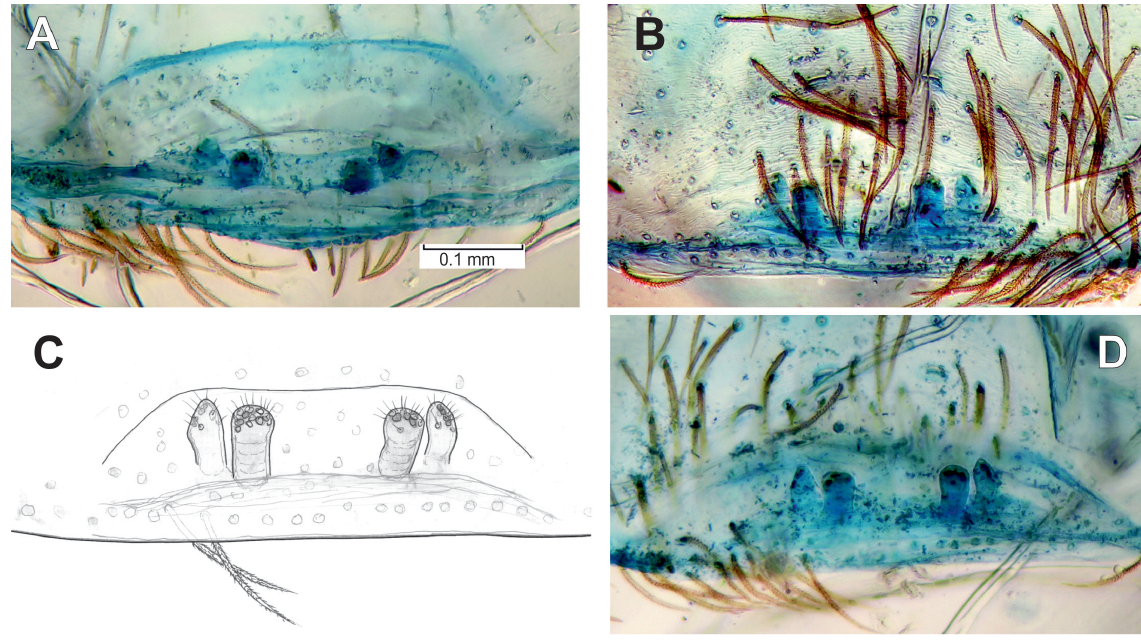
Fig. 40. endogyne of Zaitunia minuta sp. nov., holotype, ♀. A . anterior. B . Ventral. C– D .